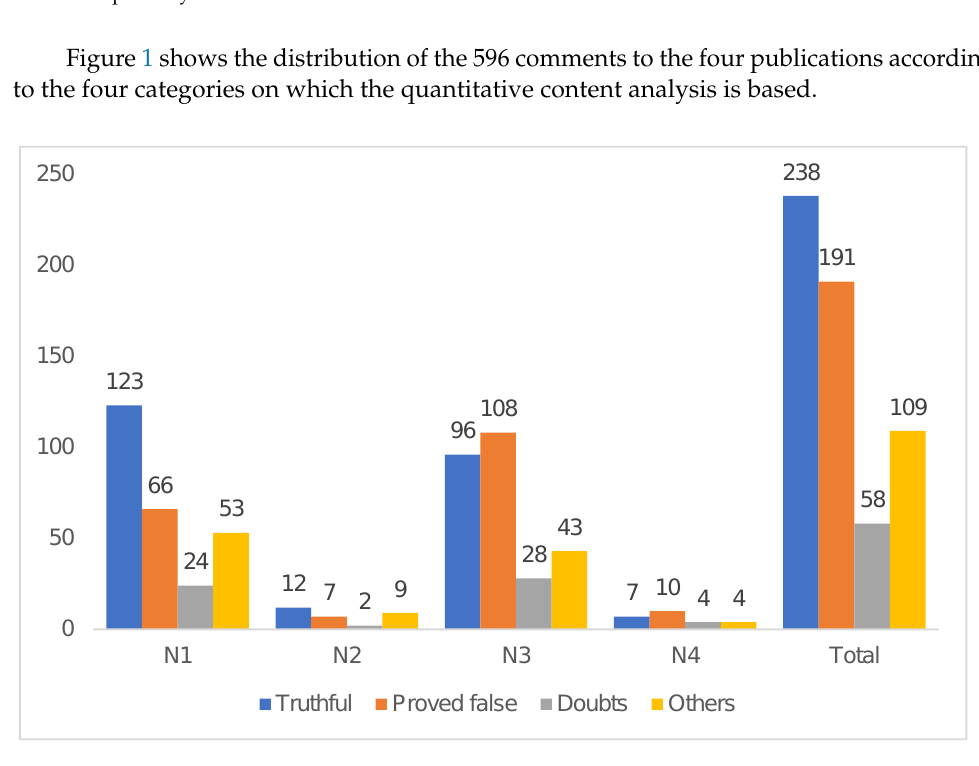
Figure 1. Distribution of social audience comments on Twitter. Source: prepared by the author.